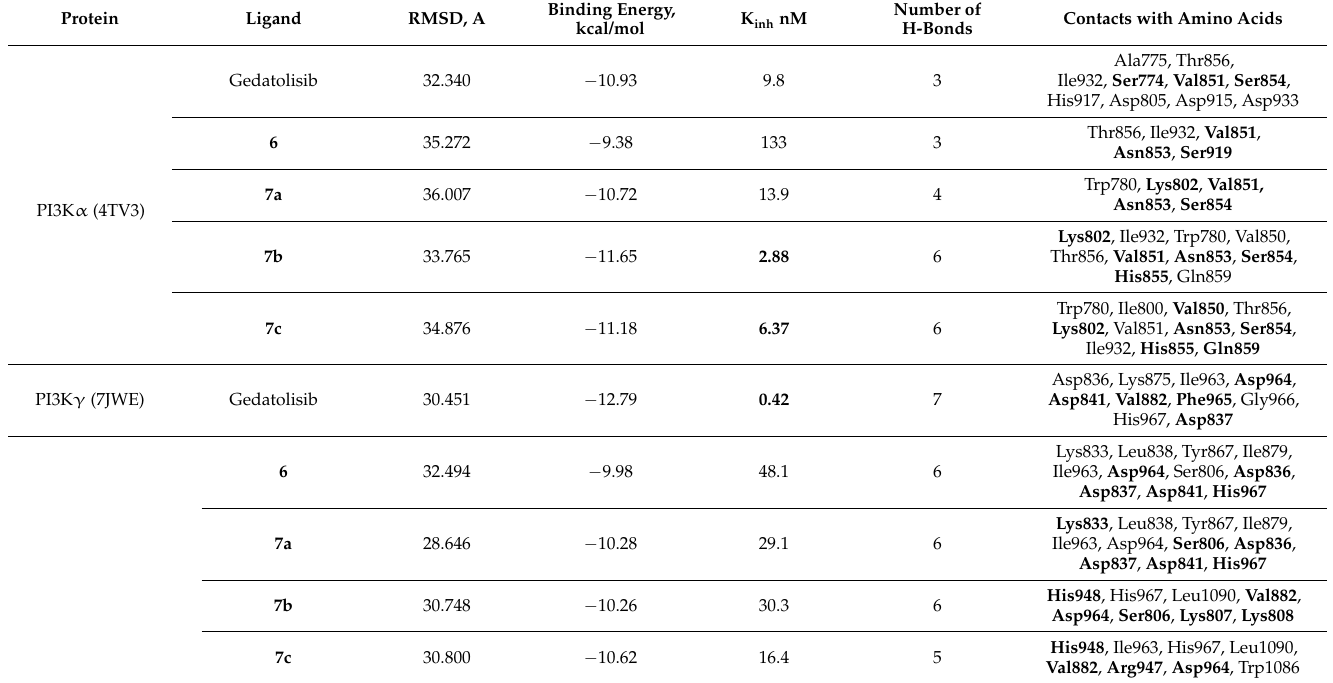
Table 2. Docking results of the selected compounds and gedatolisib into catalytic sites of PI3K α and PI3K γ